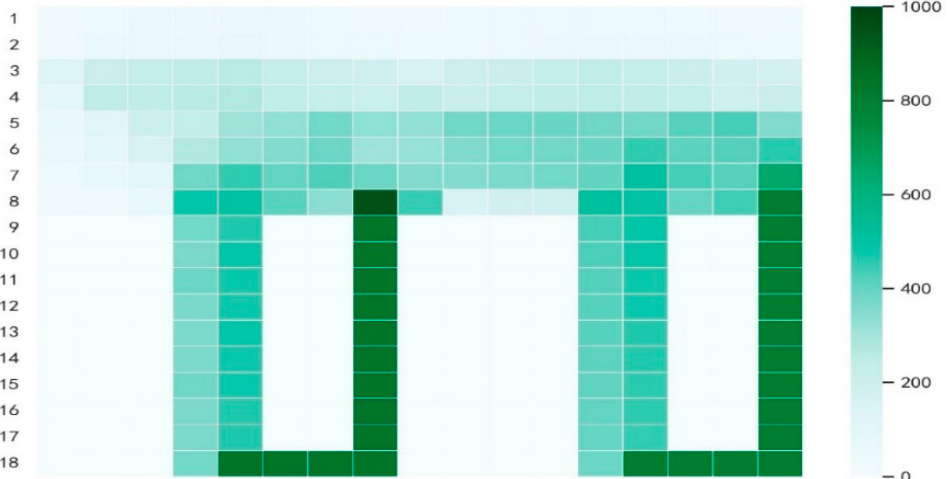
Figure 11. Heat map of the walking path of the horizontal IGV